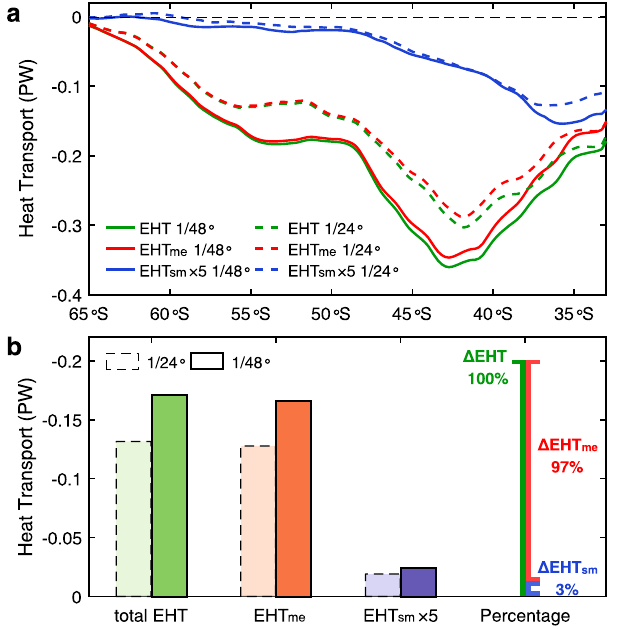
Fig. 2 | Latitudinal distributions and comparisons of eddy heat transports. a Green, red, and blue lines denote the total, mesoscale, and submesoscale eddy heat transports (EHTs), respectively. Results from the 1/48° and 1/24° simulations aredenotedusingsolidanddashedlines,respectively.Notethatthesubmesoscale EHT has been ampli fi ed by a factor of 5. b Averaged EHTs in the Antarctic Cir- cumpolar Current band (i.e., 40 – 65 o S) with the colors having the same meanings with a . Dark colors with solid-line edge and light colors with dashed-line edge denote results from the 1/48° and 1/24° simulations, respectively. The rightmost histogram shows the percentage partition of the increased mesoscale EHT (97%) and submesoscale EHT (3%) of the total EHT increase. Comparisons of different EHTs suggest that the better resolving of submesoscale eddies enhances not only the submesoscale EHT but also the mesoscale EHT. The enhanced total EHT is dominantly attributed to the mesoscale EHT